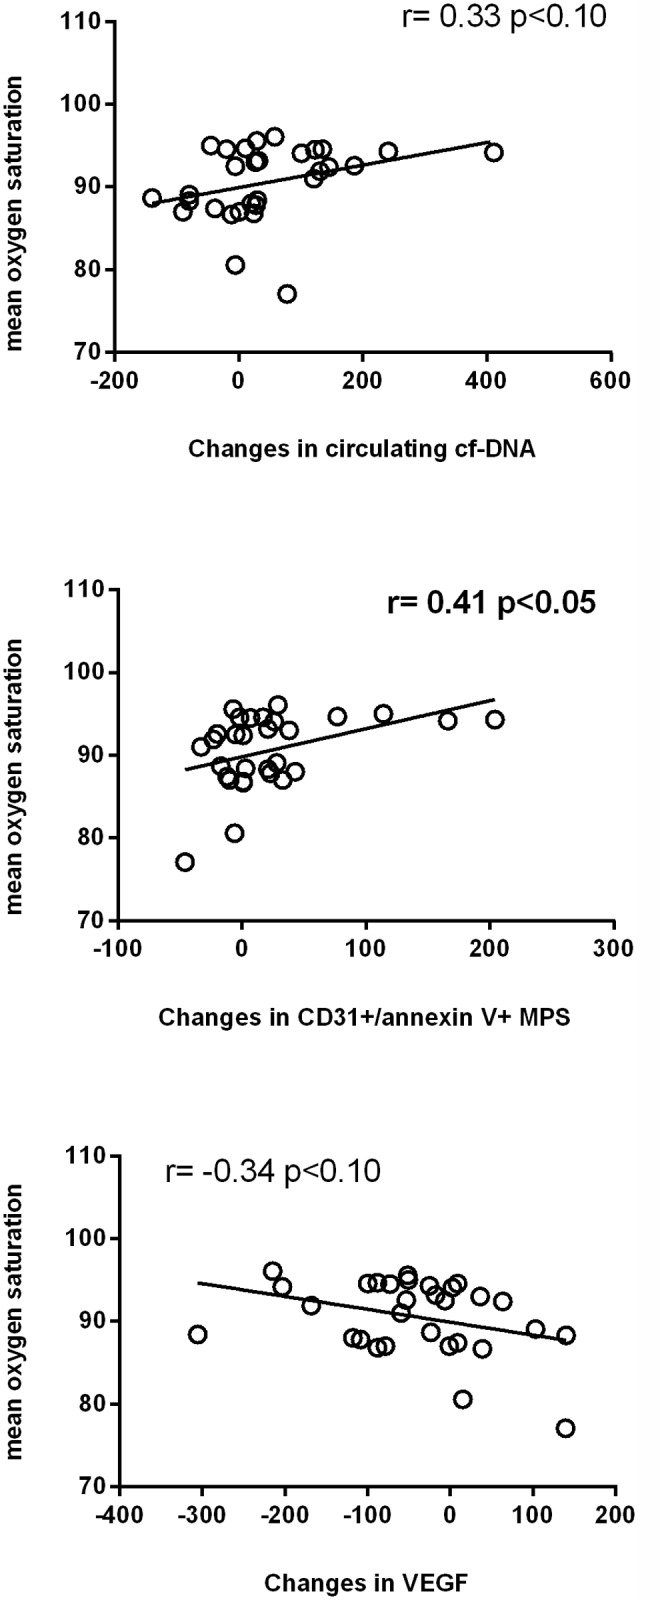
Relationship among the severity of the disease measured according to the mean oxygen saturation (%), and changes from baseline in circulating cf-DNA, CD31+/annexin V+ MPs and vascular endothelial growth factor (VEGF).